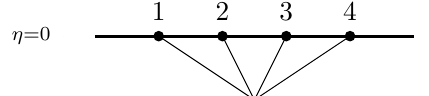
Figure 6 . Four-point contact Witten diagram.